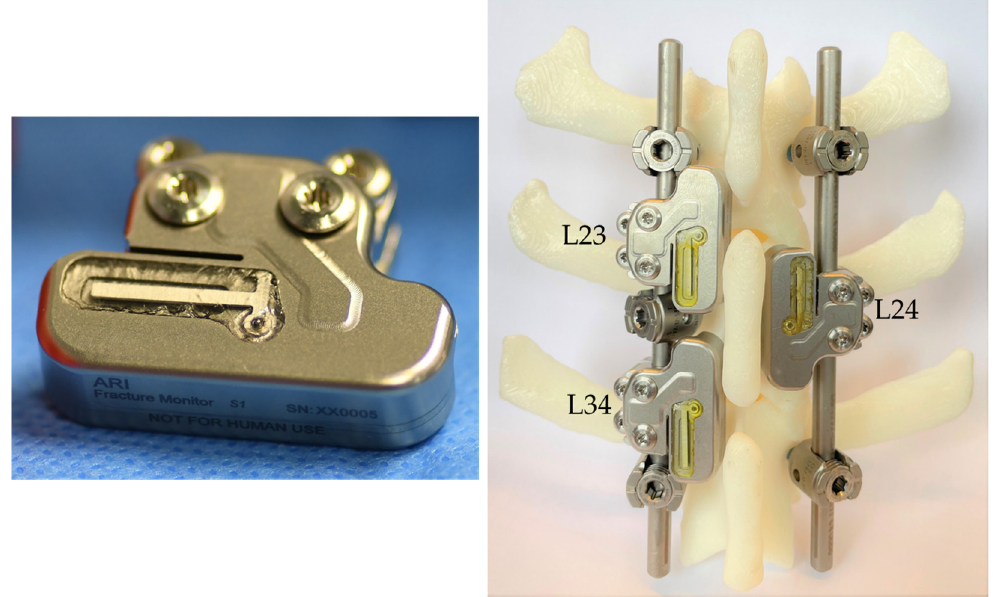
Figure 1. ( Left ) Spine sensor prototype as modified from an existing trauma sensor. ( Right ) Posterior instrumentation arrangement with attached sensors as used in the in vivo study on a 3D-printed ovine spine model (L2 – L4).